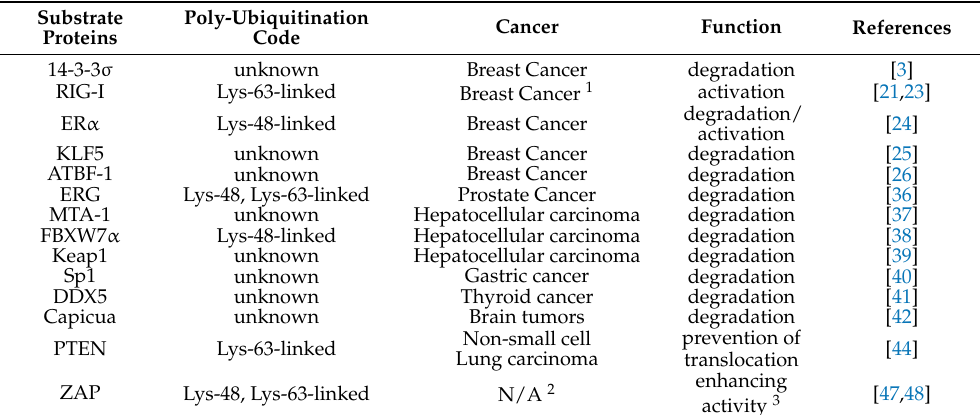
Table 1. Substrates of